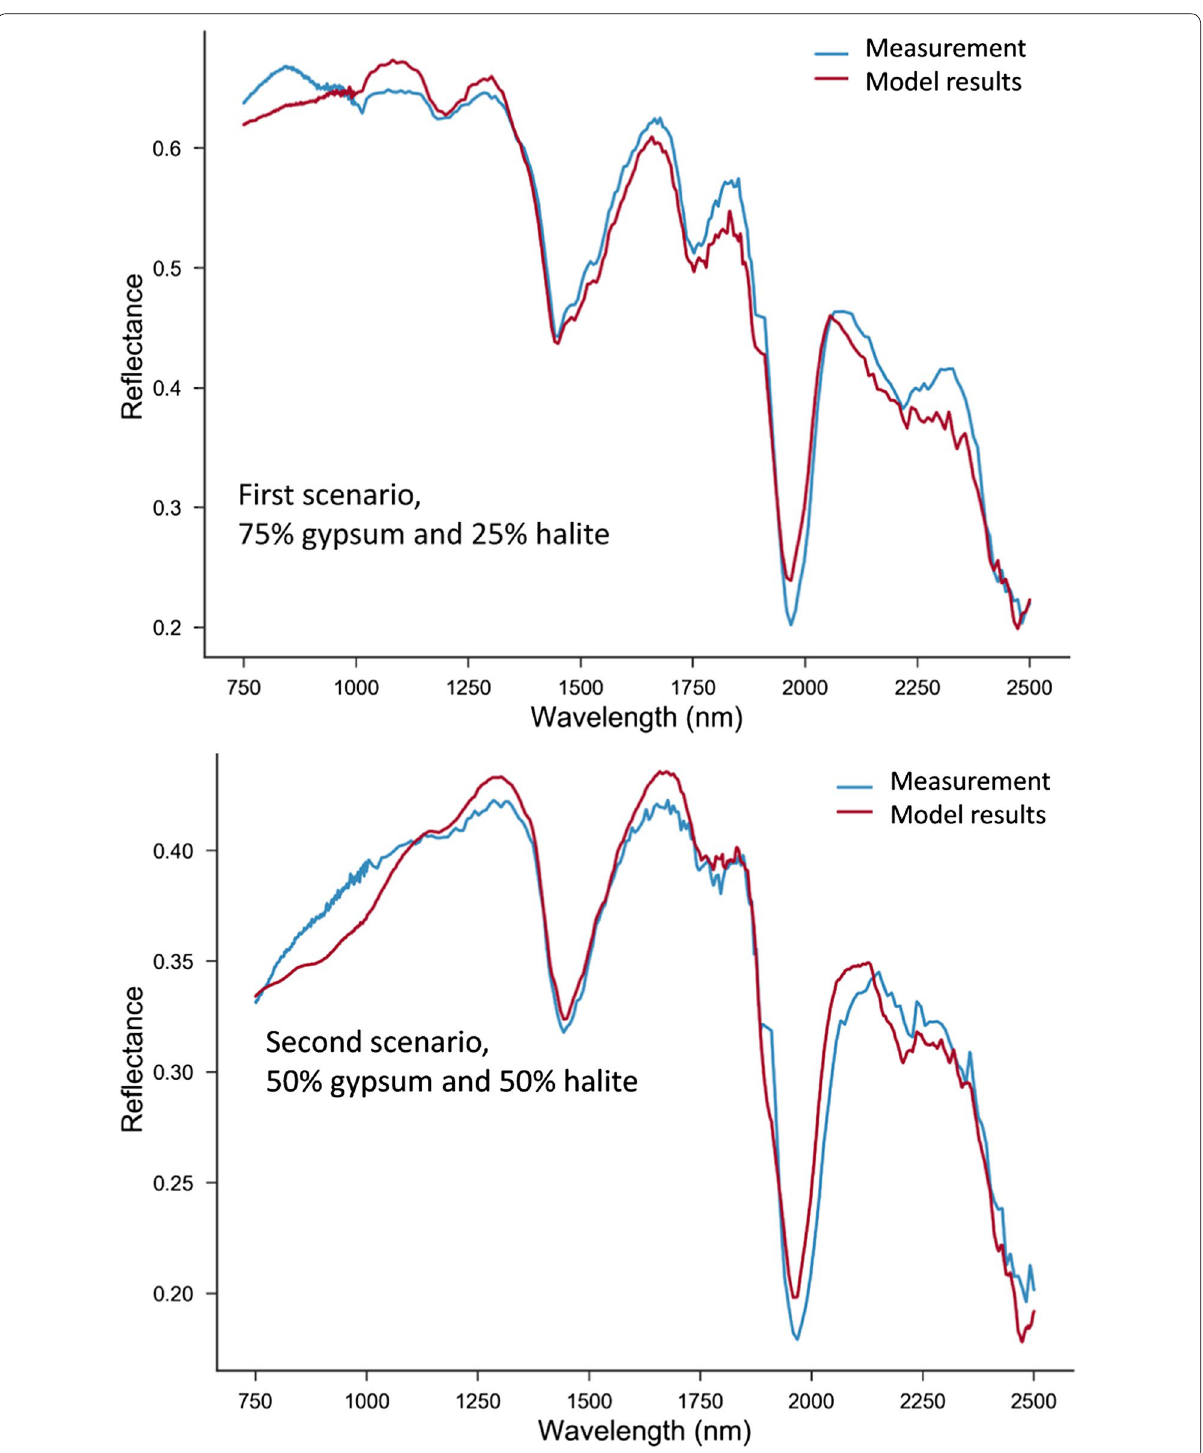
Fig. 8 Comparison between the modeled and measured spectra for the first and second mixing